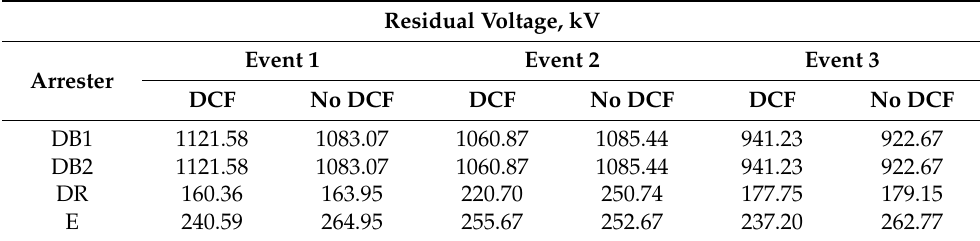
Table 9. Residual voltages of arresters for switching